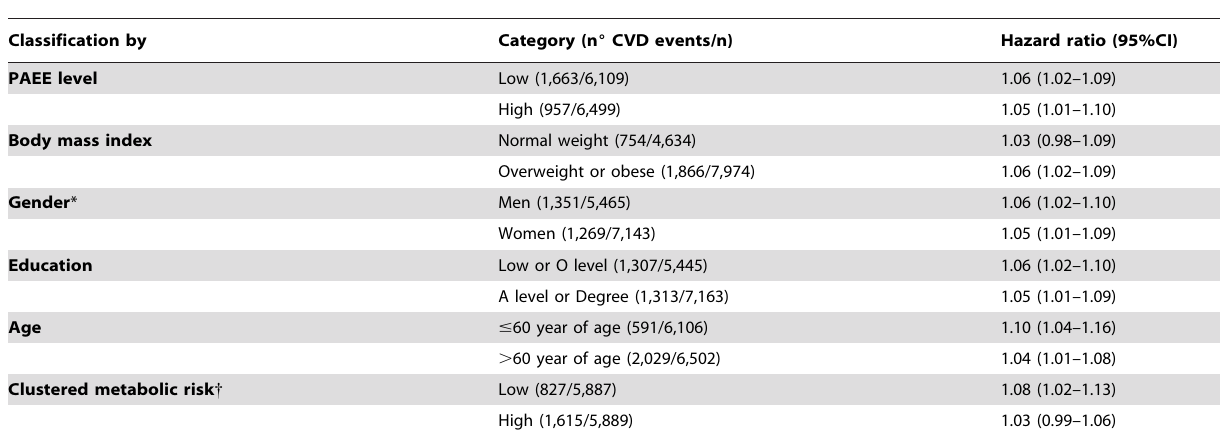
Table 4. Hazard ratios (95%CI) for any cardiovascular disease event per hour/day increase in television viewing in subgroups according to physical activity level, body mass index, gender, education level, age and clustered metabolic risk, in 12,608 men and women in EPIC Norfolk, 1998–2007.